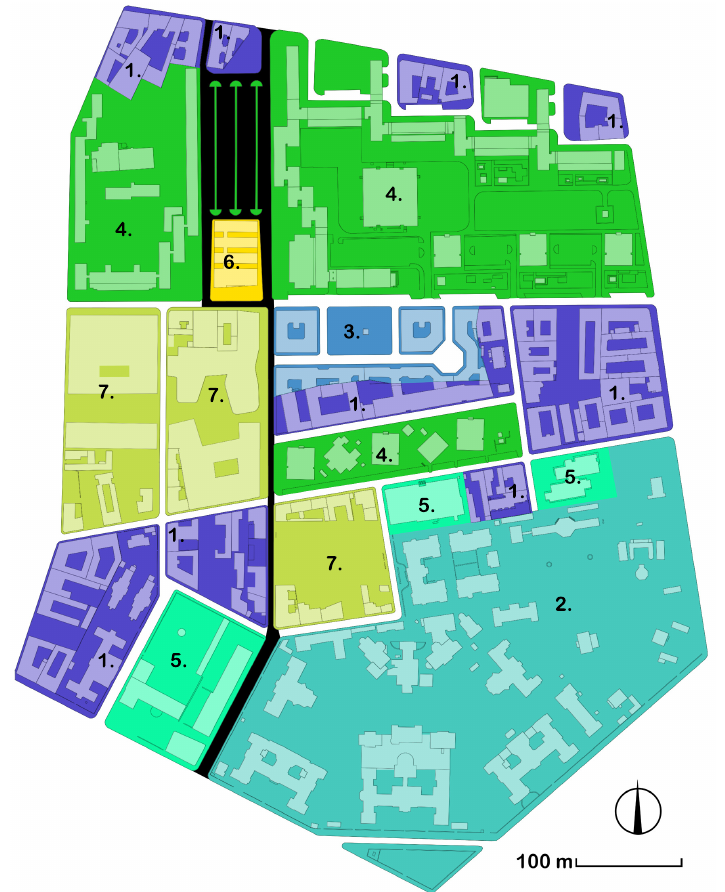
Figure 5. Contemporary urban fabric composed of different morphological units reflects disrupted developments. Legend: Corvin Street (black), (1) historic tenement buildings, (2) Clinics, (3) historic housing estate, (4) modern mass housing, (5) modern public buildings, (6) university building, and (7) Corvin